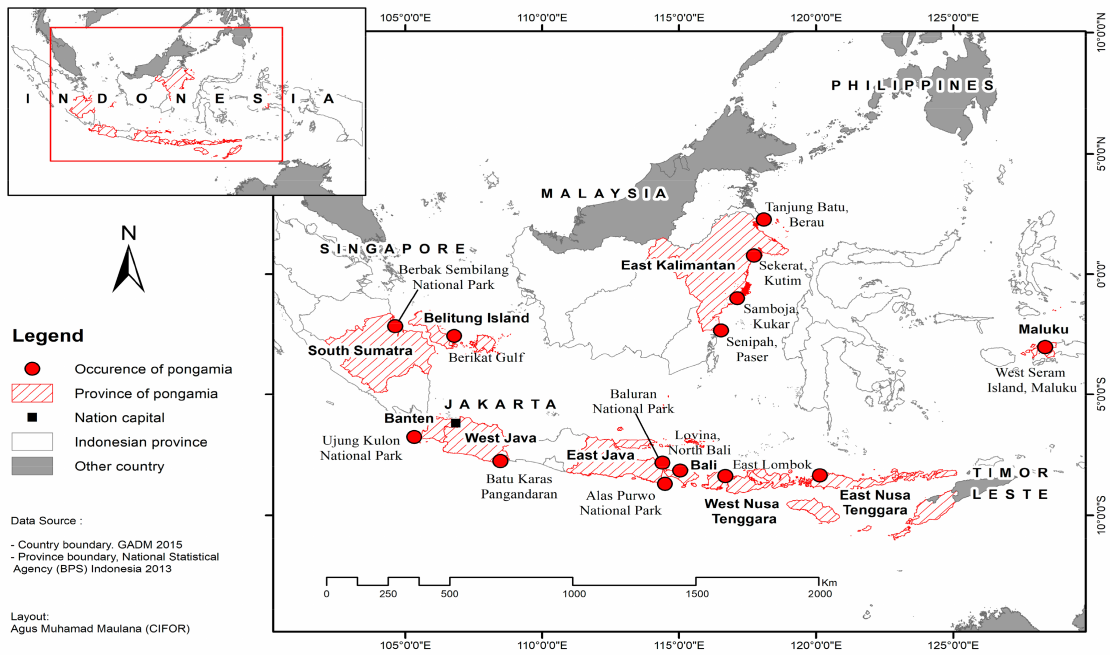
Figure 2. Natural distribution of pongamia in Indonesia, adapted from Refs.